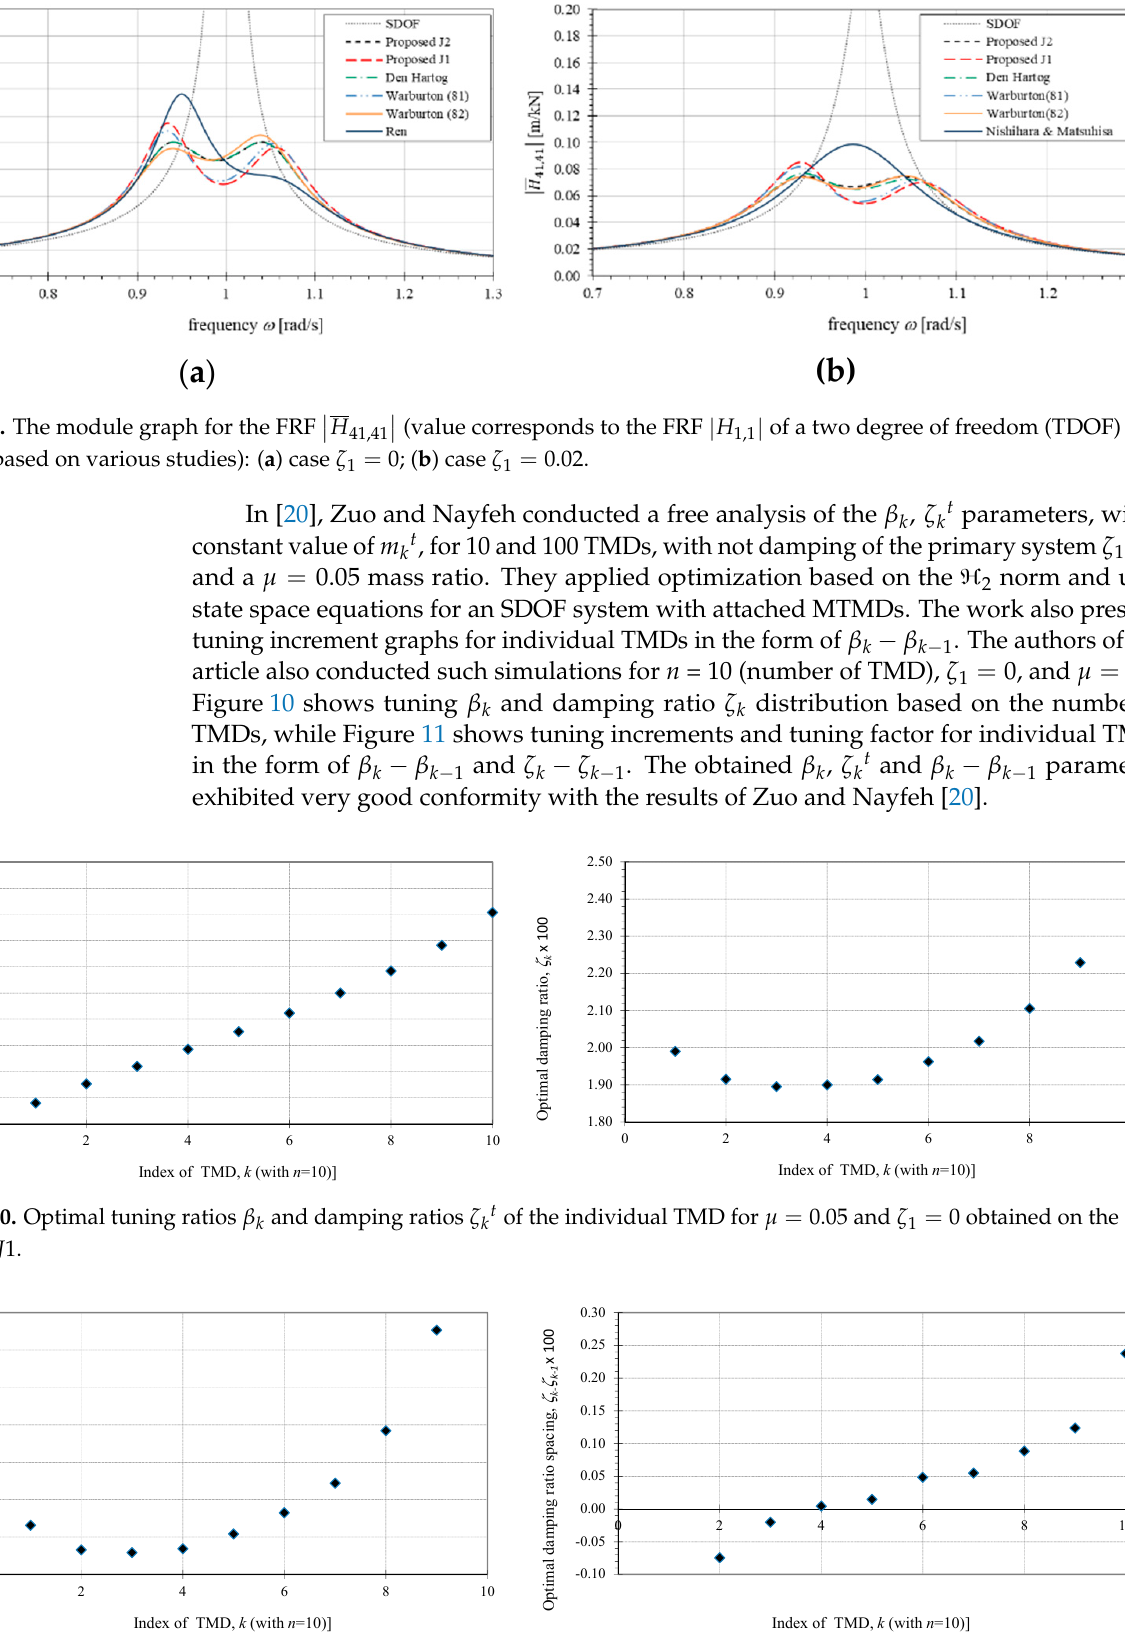
Figure 11. Optimal tuning spacings β k − β k − 1 and damping ratios spacings ζ k − ζ k − 1 of the individual TMD for µ = 0.05 and ζ 1 = 0 obtained on the basis of J